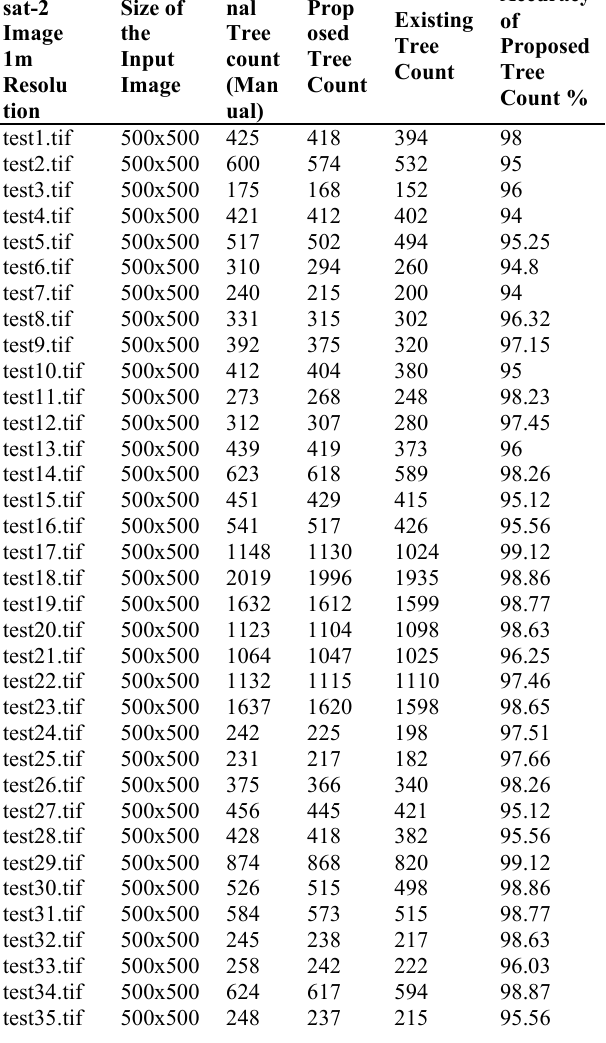
Table 2. Performance Accuracy